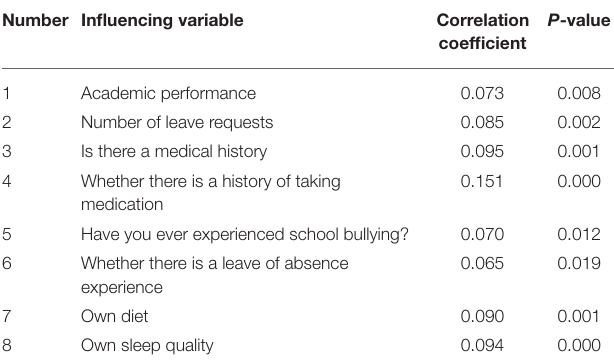
TABLE 2 | Kendall analysis